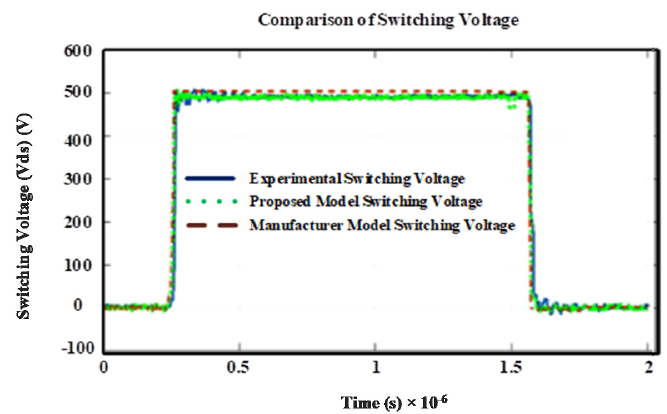
Figure 17. Comparison of switching voltage waveforms of models with DPT results.